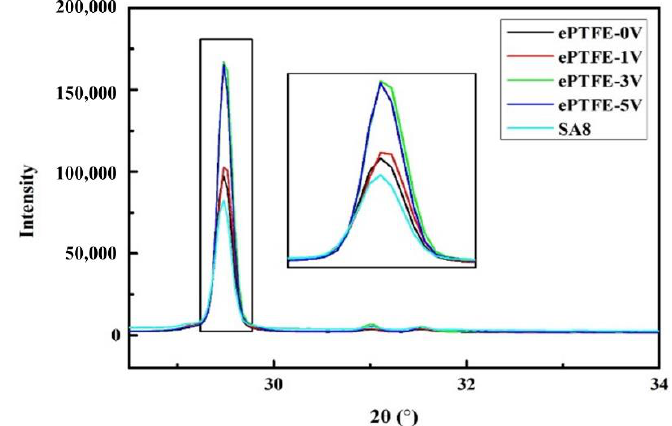
Figure 5. XRD diffraction section of SA8 and ePTFE membrane, 20 – 80°.